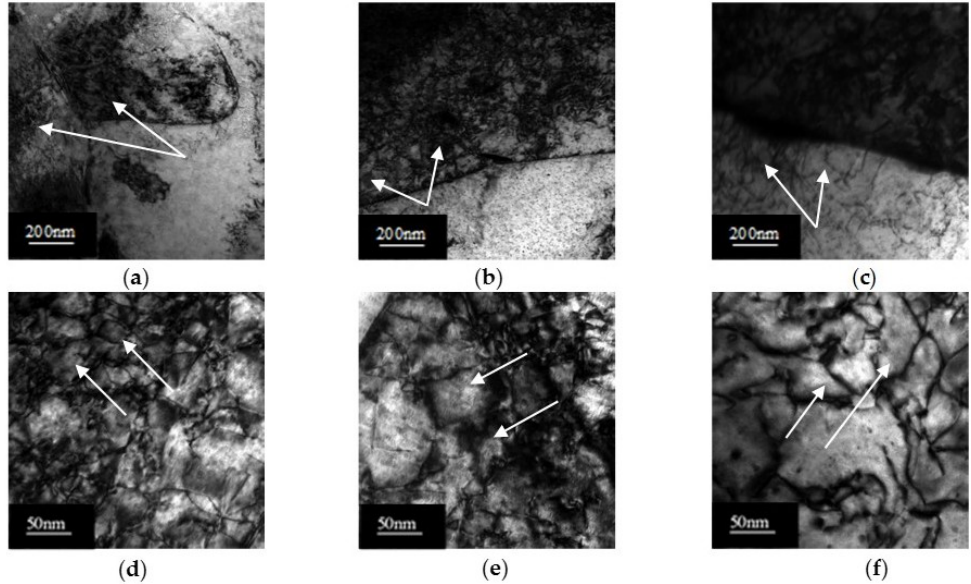
Figure 3. TEM micrographs of LCHB steel showing the dislocation distribution close to the grain boundaries ( a ) rolled at RT = 790 °C, rolling rate ratio = 1000:1000, ( b ) rolled at RT = 830 °C, ( c ) rolled at RT = 870 °C; and cell structure of dislocations ( d ) rolled at RT = 790 °C, rolling ratio = 1000:1000, ( e ) rolled at RT = 830 °C, rolling ratio = 1000:1000, ( f ) rolled at RT = 870 °C, rolling ratio = 1000:1000. The cell structures in all images are indicated by the arrows.